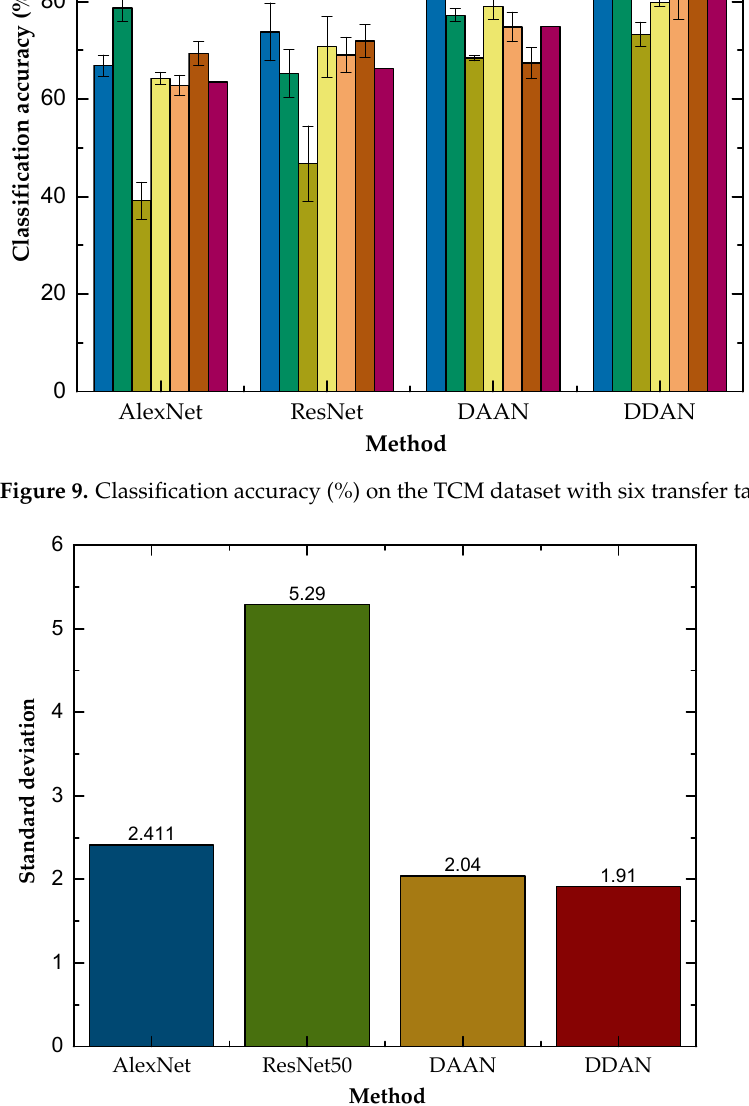
Figure 9. Classification accuracy (%) on the TCM dataset with six transfer tasks. Figure 10 reflects the average standard deviation of each method for the six transfer